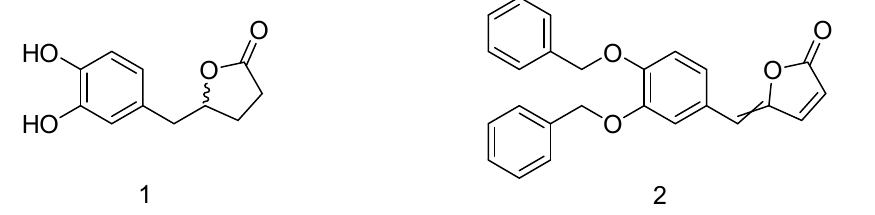
Figure 1. 5-(3 (cid:48) ,4 (cid:48) -Dihydroxyphenyl)- γ -valerolactone ( 1 ) and 5-(3 (cid:48) ,4 (cid:48) -bis(benzyloxy)benzylidene)furan- 2(5 H )-one ( 2